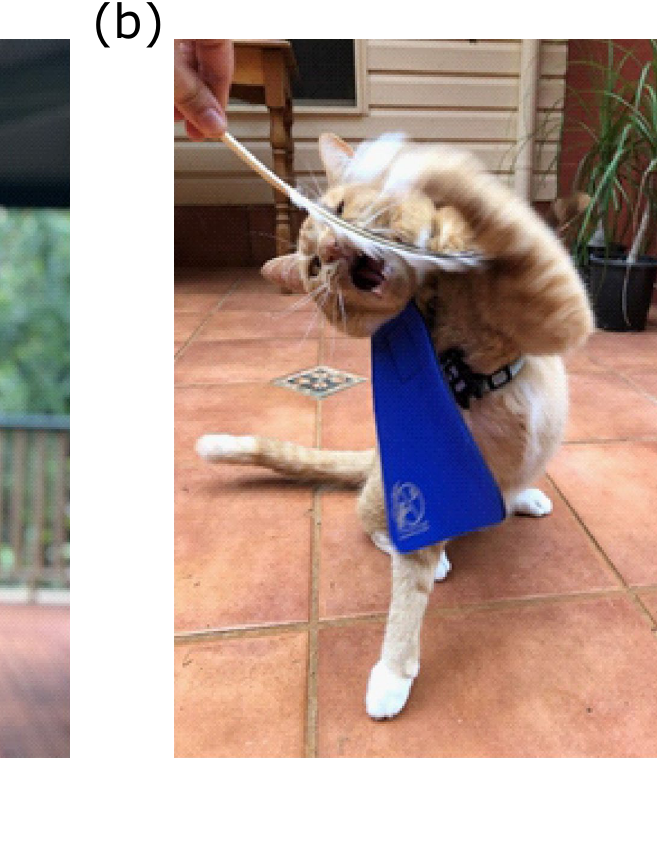
for fore-aft (surge), lateral (sway) and dorso-ventral (heave) movement to be reflected in the X, Y and Z signals, respectively (Fig. 1c). The accelerometer harness was used in conjunction with the CatBib for the relevant treatment periods. The total combined mass of the harness, accelerometer and Catbib was to 34.1 g, with a minimum cat mass of 2.8 kg, suggesting the equipment did not weigh above 1.2% of total body weight in any cat studied. The CatBib is a prey protector device, manufactured from a lightweight, washable neoprene material, that is attached to a cat’s safety collar (Fig. 1b). The dimensions of the bib are 17.5 mm × 17.5 mm × 6.5 mm, with a total mass of 23.1 g and it is purple in colour. All cats adjusted to the harness and CatBib within the first hour of deployment and no